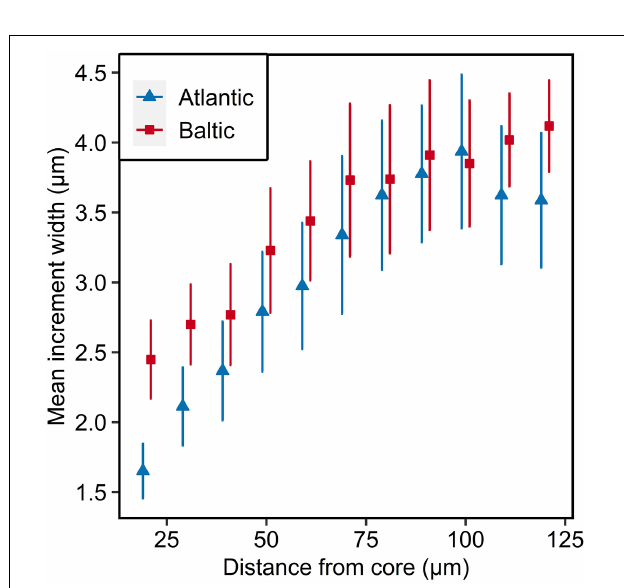
FIGURE 2 | Otolith microstructure of parental Atlantic (blue) and Baltic (red) populations. Mean increment width ± 95% confidence intervals are given for each 10 µ m interval. Data points are offset for visual